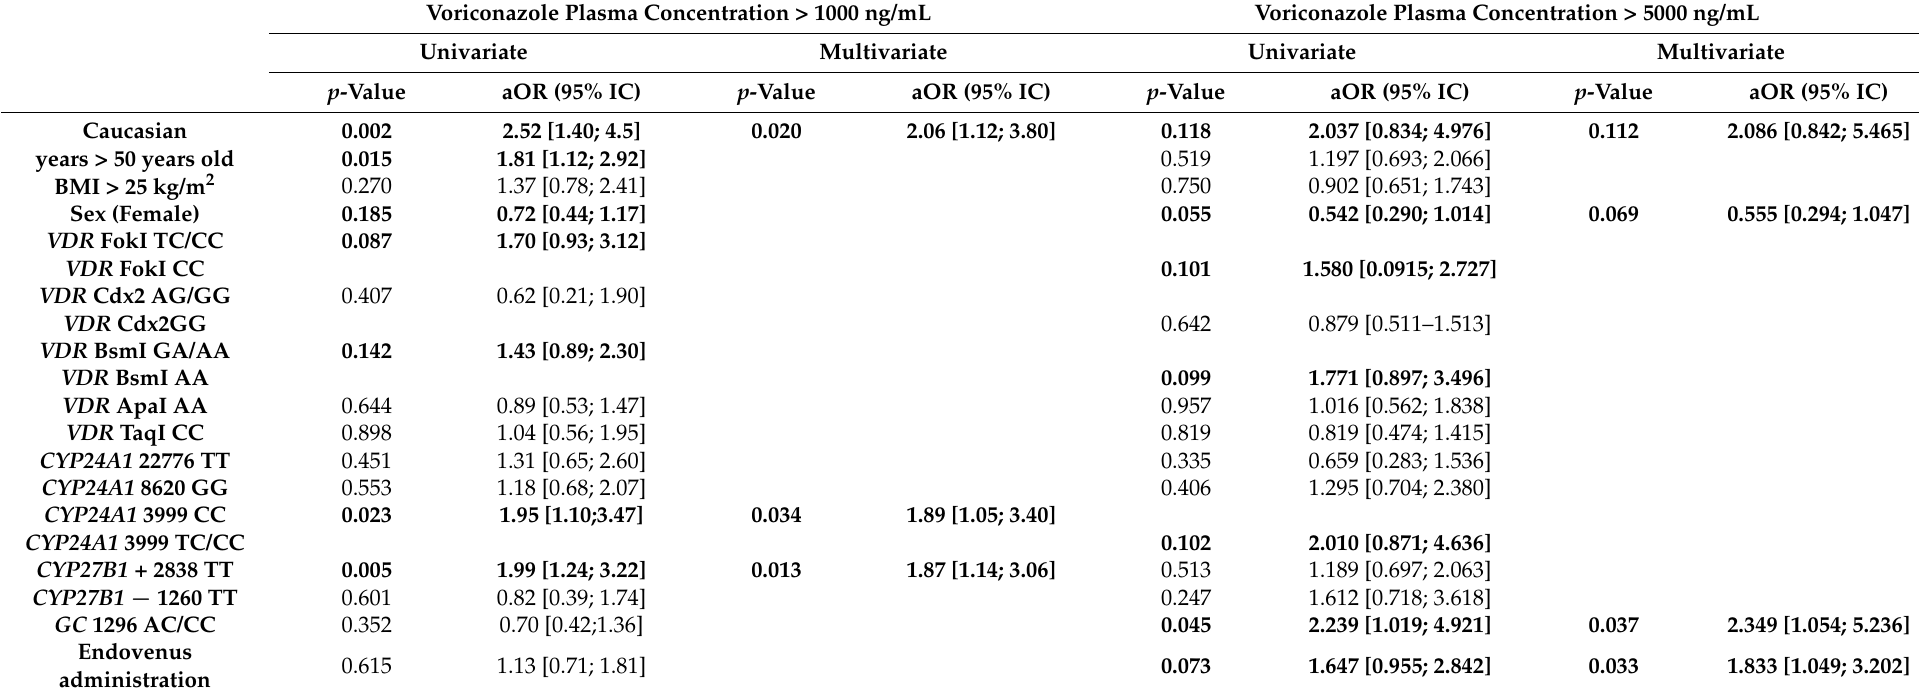
Table 2. Linear regression analysis: factors able to predict voriconazole plasma concentrations over efficacy cut-off limits (>1000 ng/mL) and toxicity cut-off limits (>5000 ng/mL). Bold characters represent statistically significant